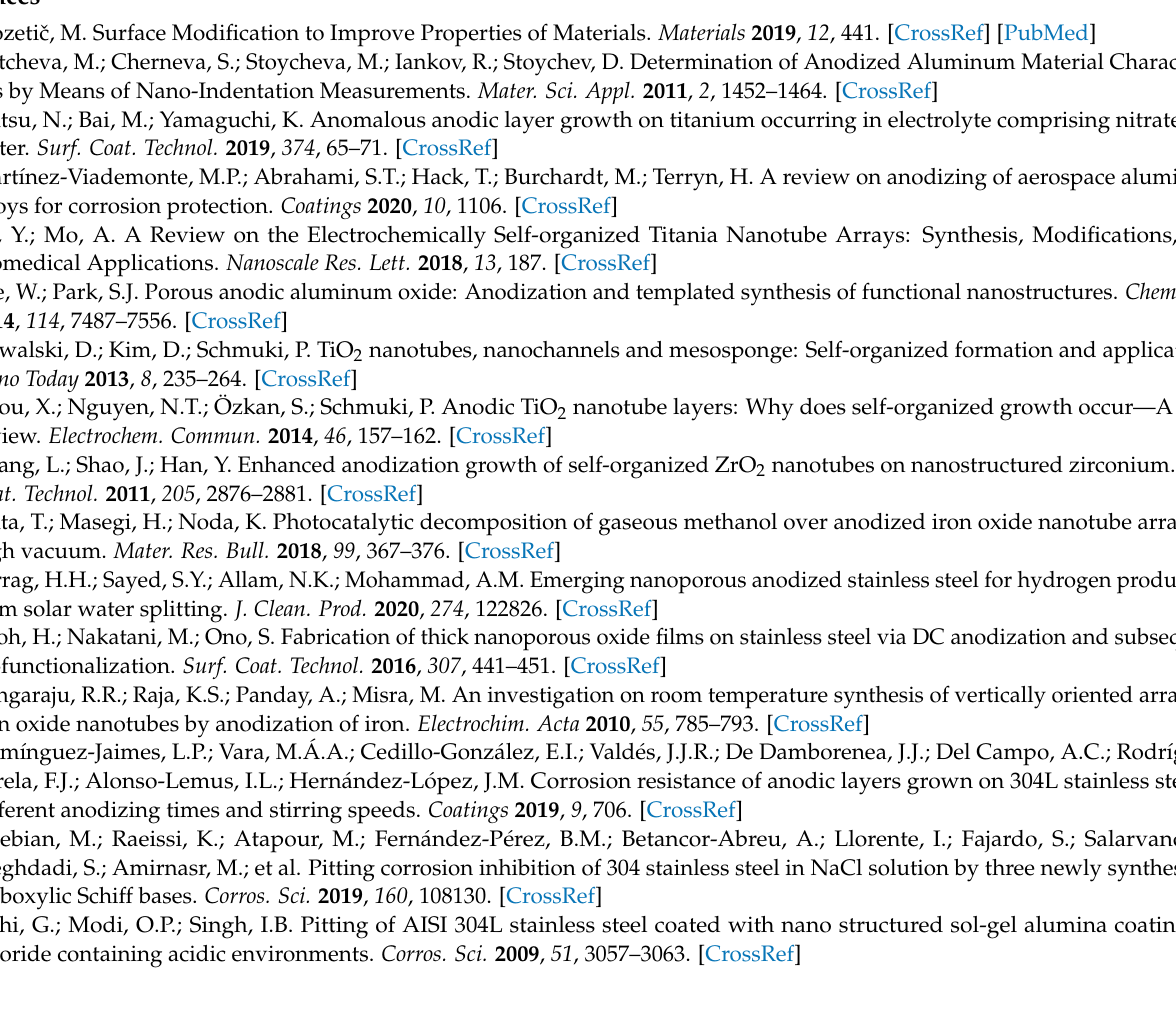
Figure S4, Voltage-time curves of the anodic layers grown in glycerol electrolyte containing 0.05